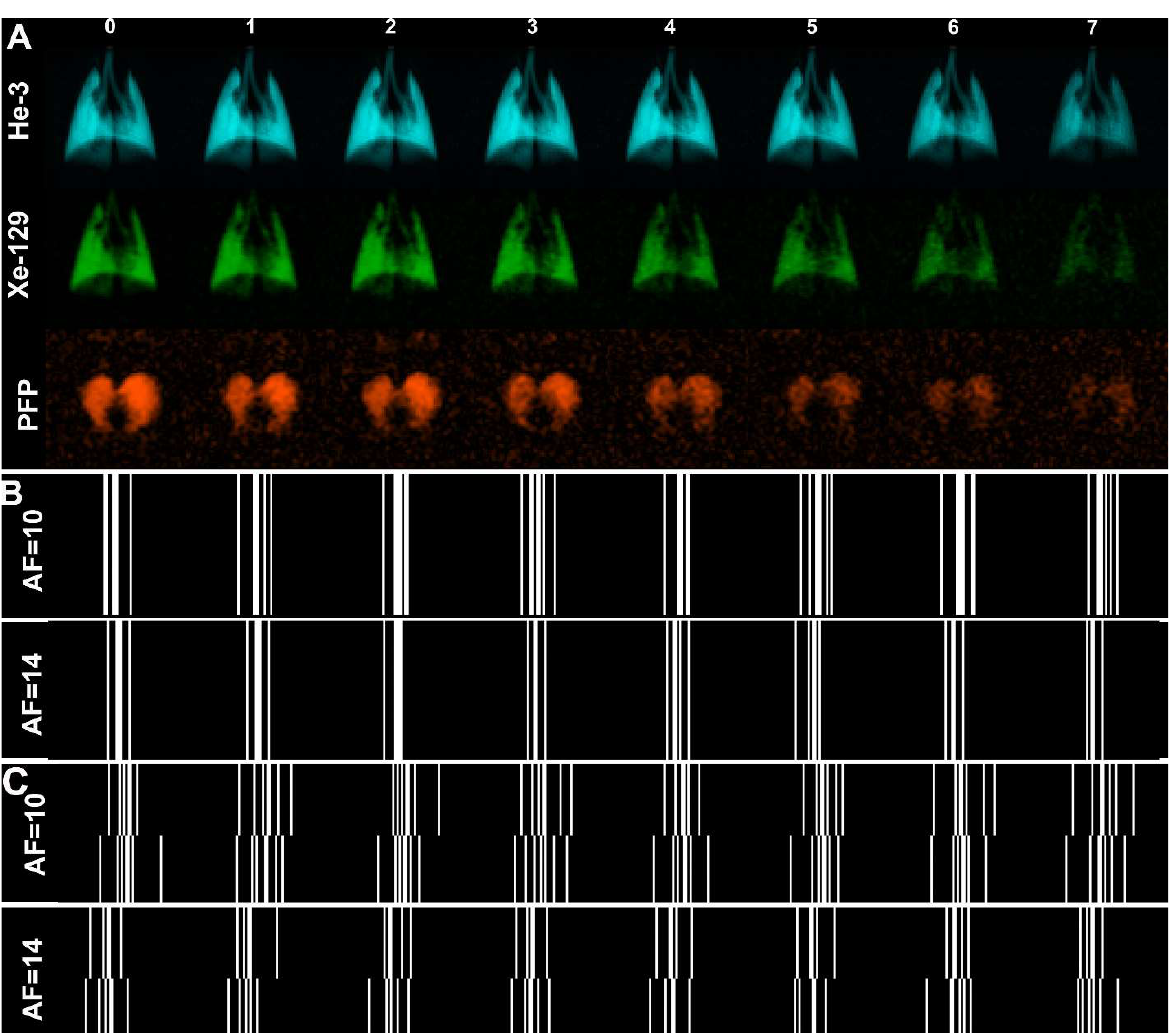
Figure 1. Wash-out 3 He/ 129 Xe/ 19 F MRI Images obtained in Normal Rats. ( A ) depicts representative eight wash-out images obtained using 3 He/ 129 Xe/ 19 F. K-space under-sampling in the phase encoding direction (fully sampled in the x-direction) schemes, ensuring a variety of sparsity patterns for each wash-out image is depicted by ( B ) AF = 10 and AF = 14 obtained for FGRE, and ( C ) AF = 10 and AF = 14 obtained for x-Centric that were retrospectively applied in wash-out direction. 3 He/ 129 Xe data were obtained using wash-in scheme. We reversed the image order to be able to fit the dynamic data with the SEM equation requiring the signal decay not signal growing. No under-sampling in the x-direction was used for FGRE while 50% under-sampling (compensated by doubling the lines in the phase encoding direction) was employed for x-Centric.